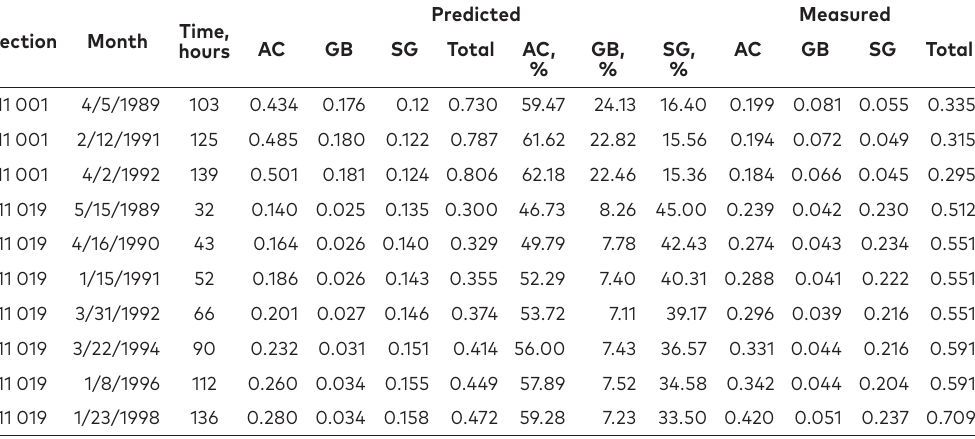
Table 2. Part of the data from Table C-58 in Appendix EE-1*